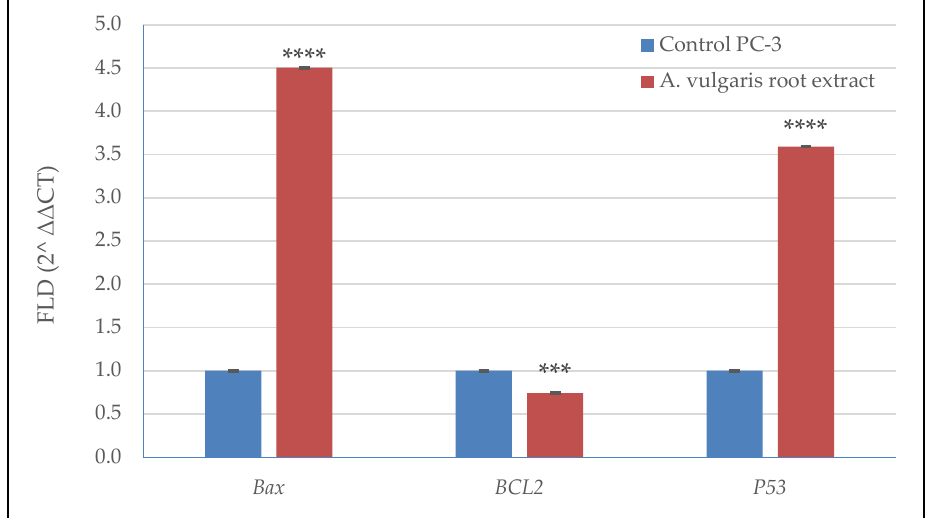
Figure 6. Expression of BAX , BCL2 and P53 genes in PC-3 cells treated with A. vulgaris root extract at 88.0 µg/mL using qRT-PCR analysis. Significance differences between treated and control cells were